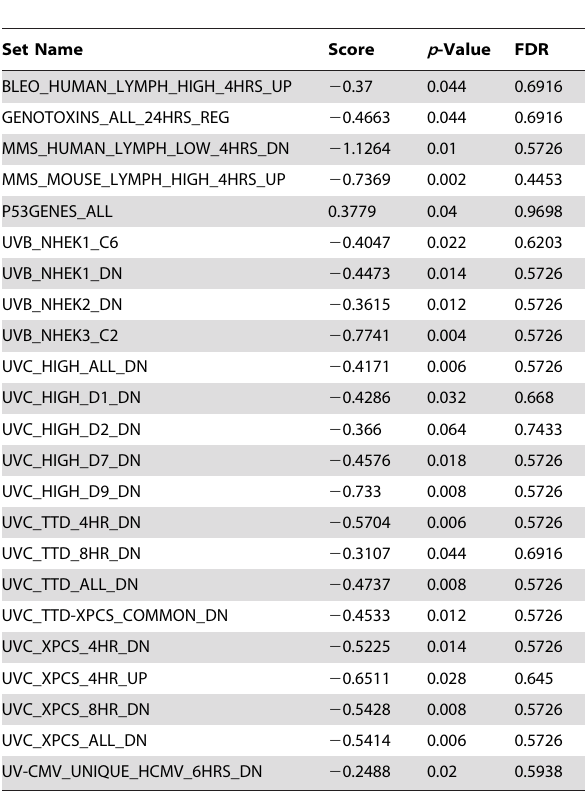
Table 1. Gene Set Analysis demonstrates a signature of DNA damage in FRDA